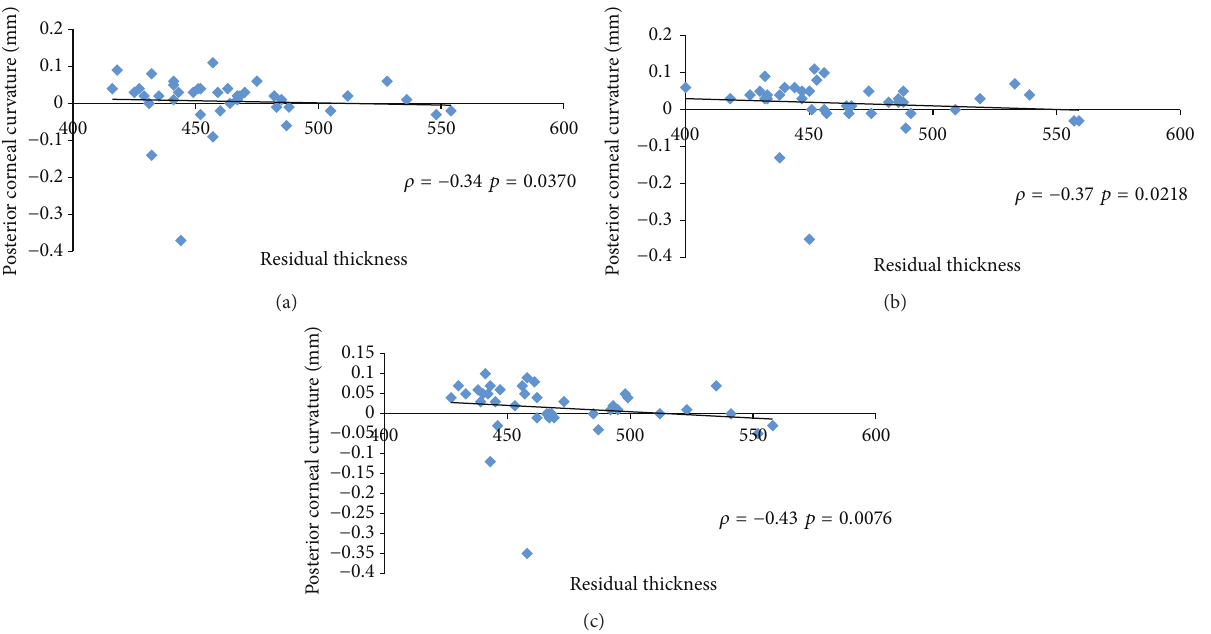
Figure 2: Spearman’s coefficient of rank correlation ( 𝜌 ) between residual corneal thickness and changes in posterior corneal curvature (mm) at 1 month (a), 6 months, (b) and one year